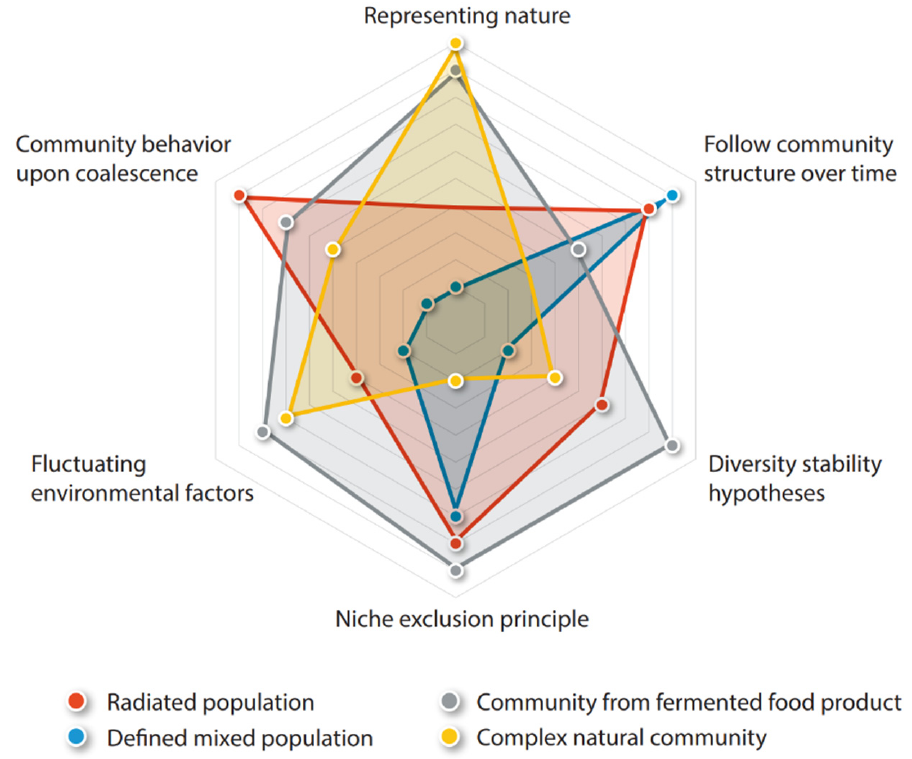
Figure 1. Different model systems and their applicability for experimental study of evolutionary theory. Values are a combined value for representability of nature and the ease of using the model systems in the experimental setup. The lowest score (1) is in the center and the highest score (10) is on the outside of the sphere. For now, more complex communities have the disadvantage of more complicated analyses, where not all players can be isolated and studied individually. When isolation and typing techniques become more available and affordable due to developments in the field of sequencing, the applicability of more complex communities as a model system will increase. Table 1. Advantages and disadvantages of various model systems. This ta ble lists the advantages and disad- vantages of using various model systems mentioned in the paper to analyse different evolutionary hypotheses. The dif- ferent hypotheses are listed in the top row, followed with a short description in the second row. Patterns of Diversity